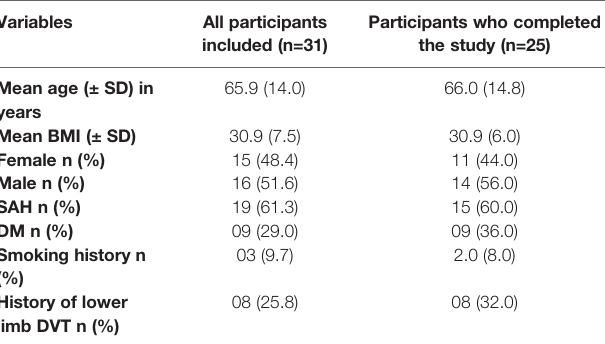
TABLE 2 | Baseline clinical characteristics of the 31 participants included in the study and the 25 participants who were followed for 12 weeks. Variables All participants Participants who completed included (n=31) the study (n=25) Mean age (± SD) in